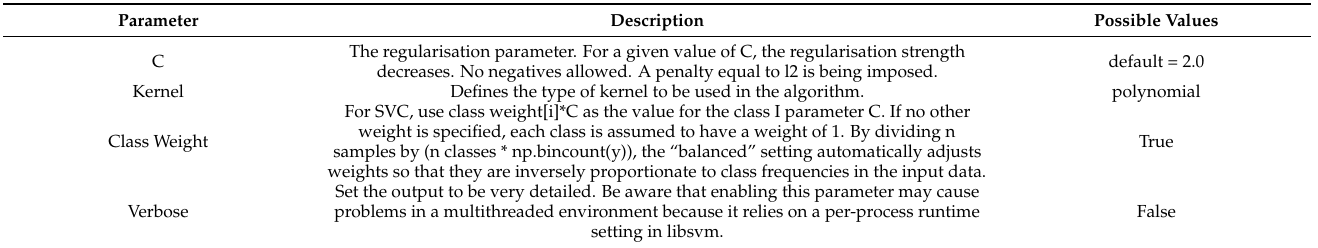
Table 6. Selected best PSO-SVM